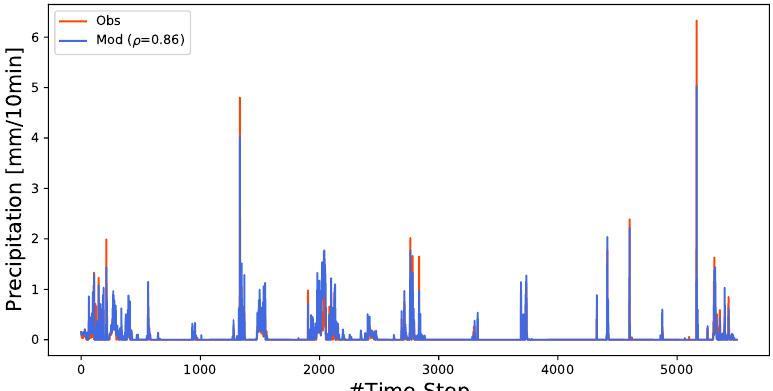
Figure A1. Observed (rain gauge data, Obs (red)) and modelled (Neural Network, Mod (blue)) precipitation at location Hohenpeissenberg in an hourly resolution on the Validation set (20% of the available data points).